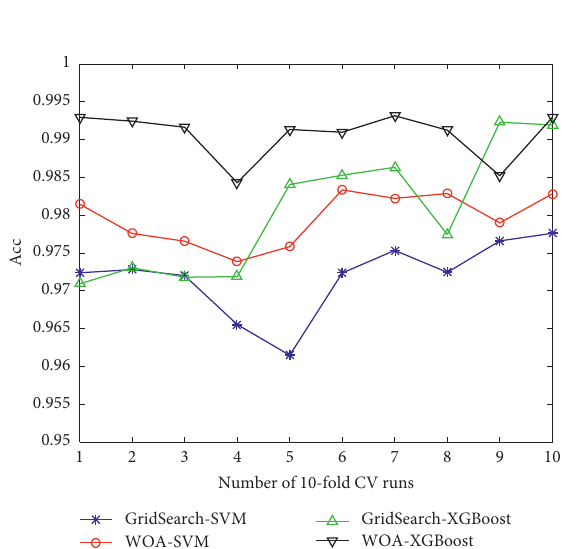
Figure 1: The ACC achieved at each run without feature